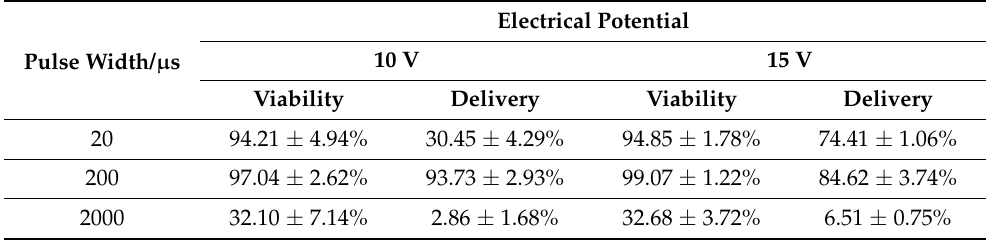
Table 2. The data of cell viability and PI delivery efficiency under each group of pulse width conditions.